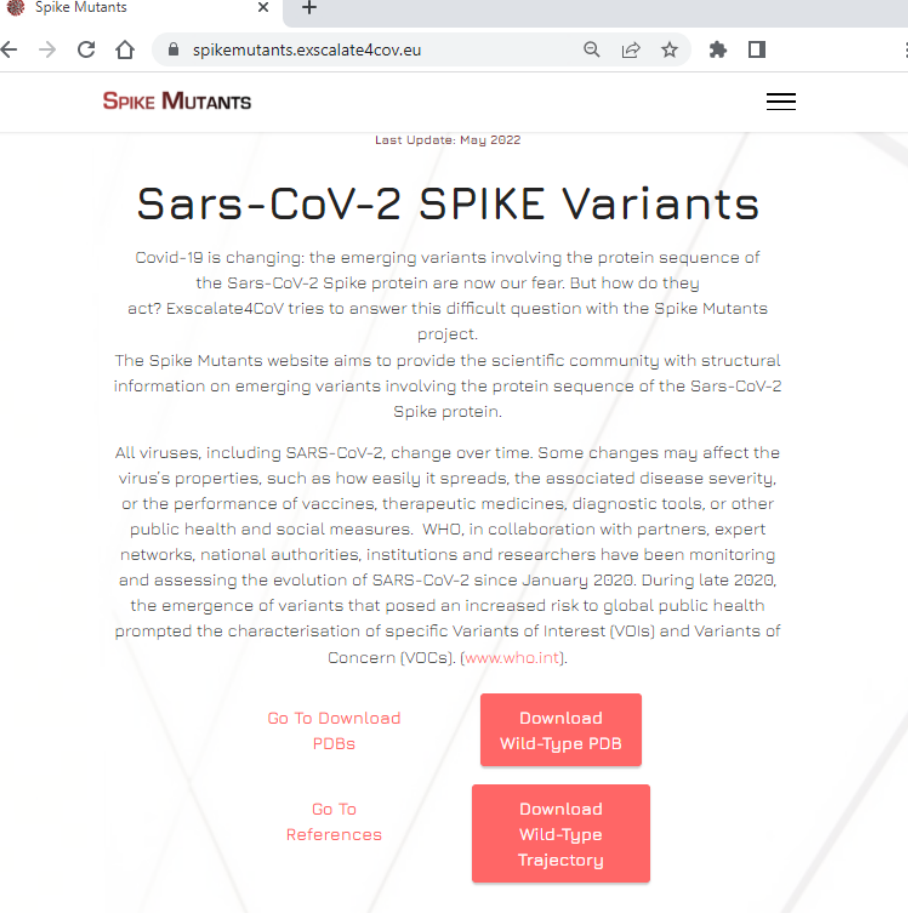
Figure 1. Snapshot of the upper portion of the Spike Mutants portal from where the 3D structure of the spike trimeric protein in glycosylated form and its corresponding MD trajectory 100 ns long can be freely